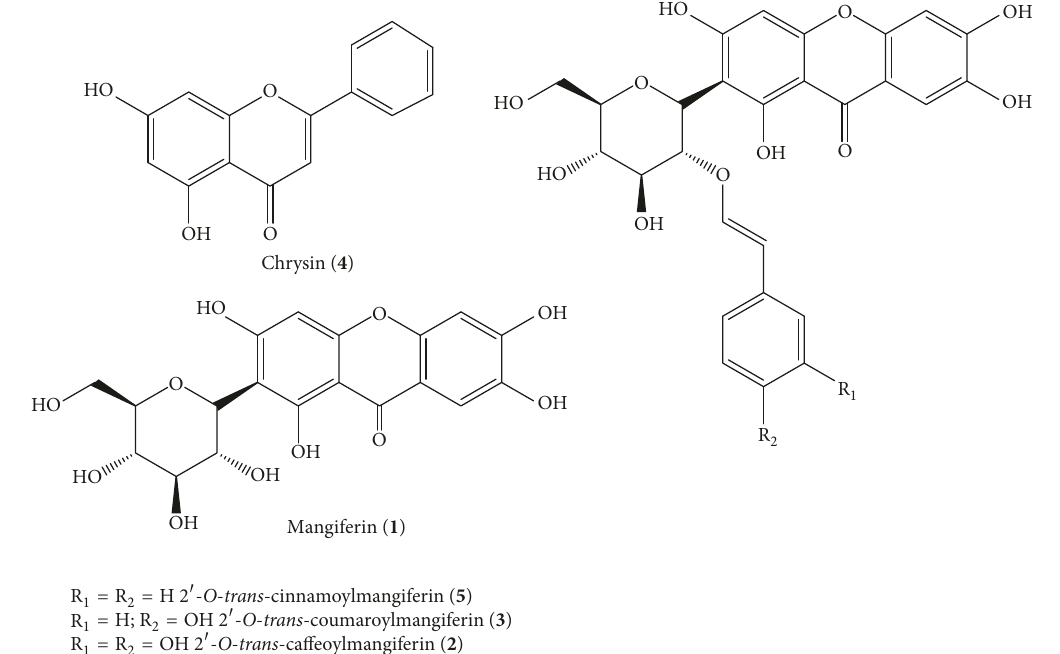
Figure 2: Chemical structures of mangiferin ( 1 ), 2 󸀠 - O - trans -caffeoylmangiferin ( 2 ), 2 󸀠 - O-trans- coumaroylmangiferin ( 3 ), chrysin ( 4 ), and 2 󸀠 - O - trans- cinnamoylmangiferin ( 5